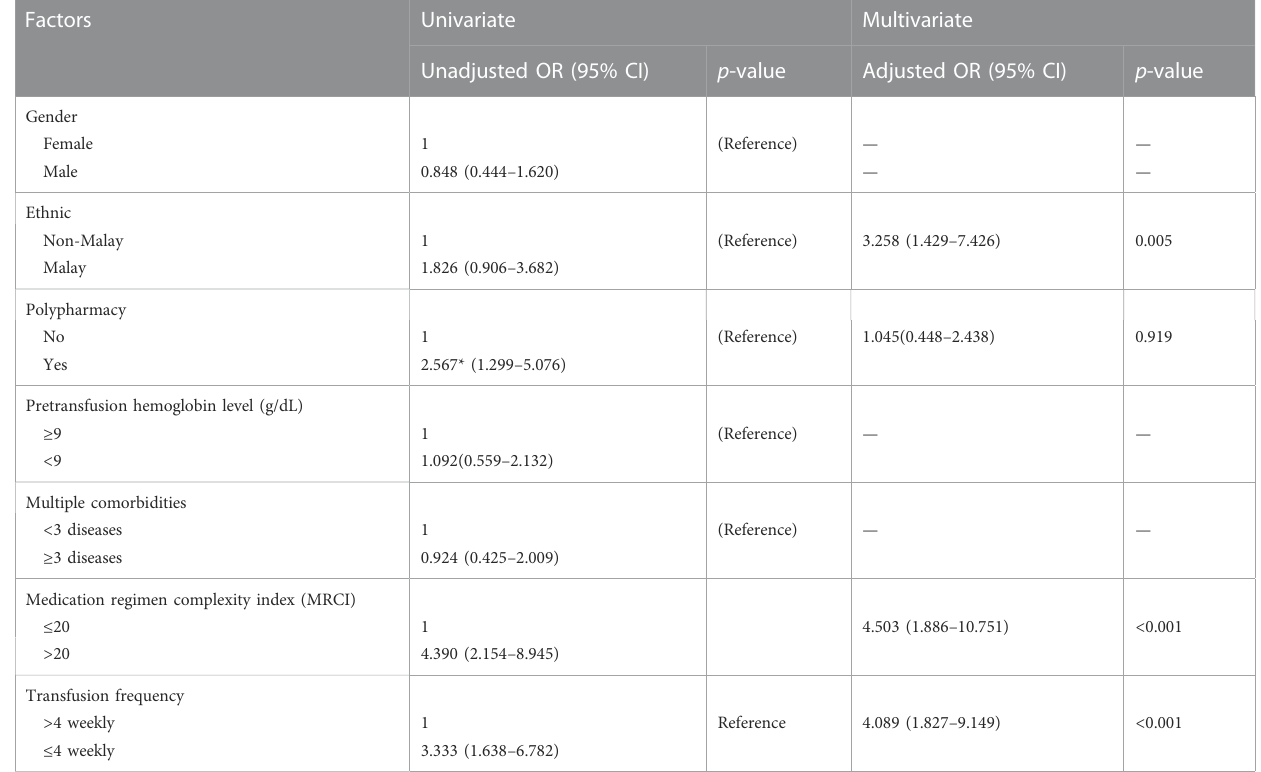
TABLE 5 Factors associated with DRP among ambulatory TDT patients in Ampang Hospital ( n = 200).